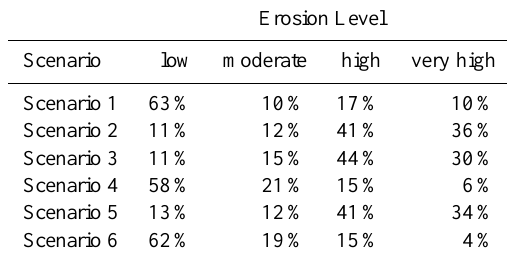
Table 7. Percentage of undertreatment area (47km 2 ) having differ- ent erosion